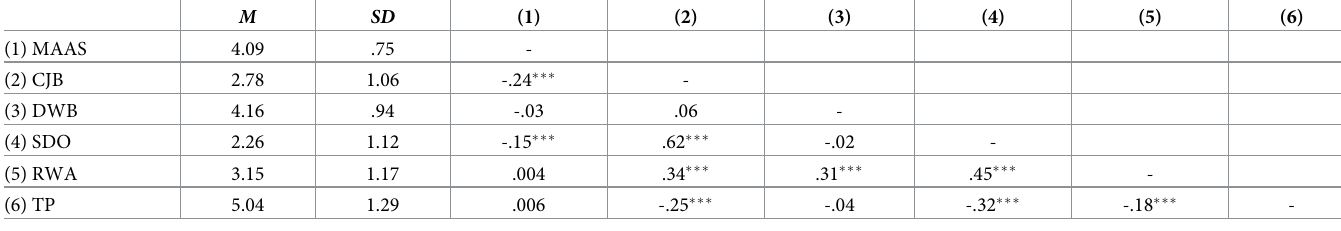
Note . Study 2 ( N = 722) ��� p <